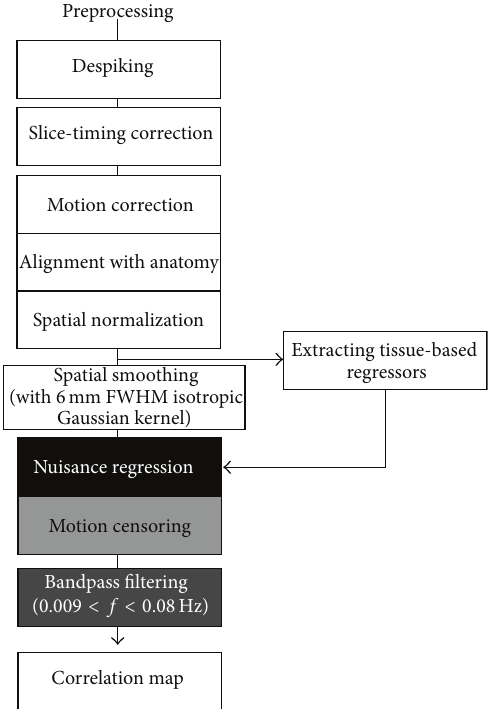
Figure 1: Overall preprocessing pipeline for this work (see text for detail of each